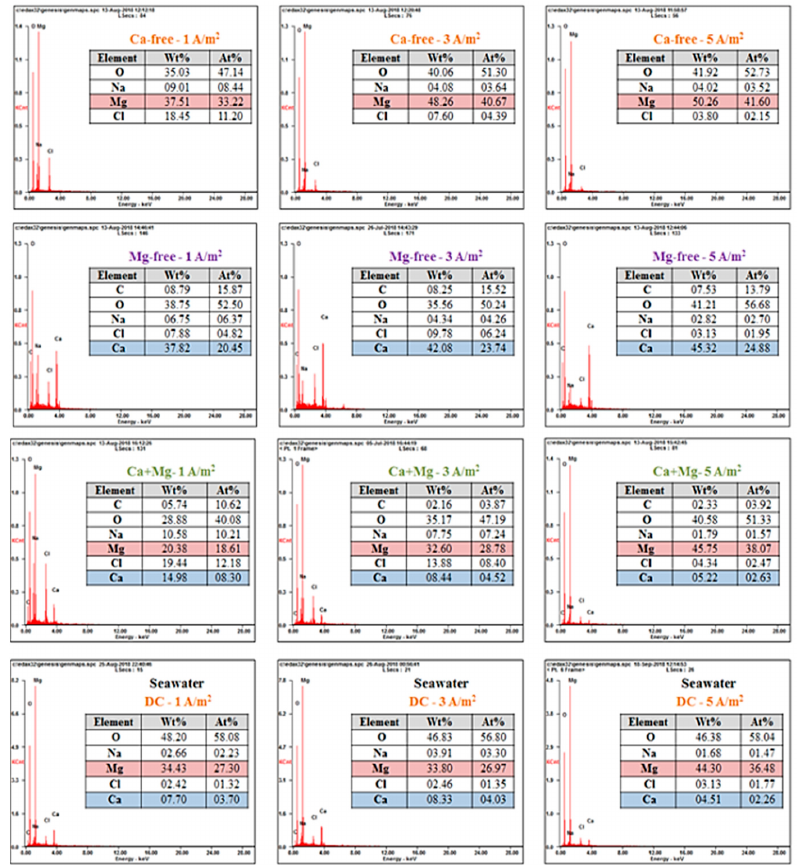
Figure 4. Elemental composition analysis of calcareous deposit films according to the current density for 24 h. Table 4. Composition ratio (Ca/Mg) analysis of calcareous deposit films after 24 h.